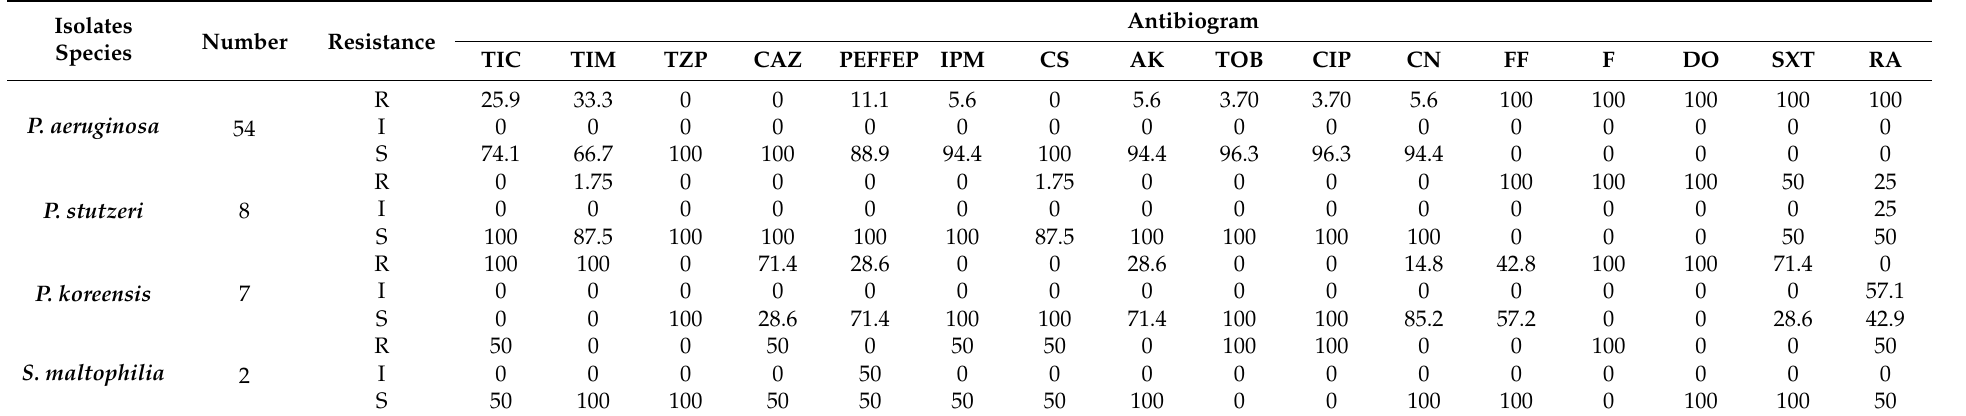
Table 3. Susceptibility of non-fermentative GNB against tested